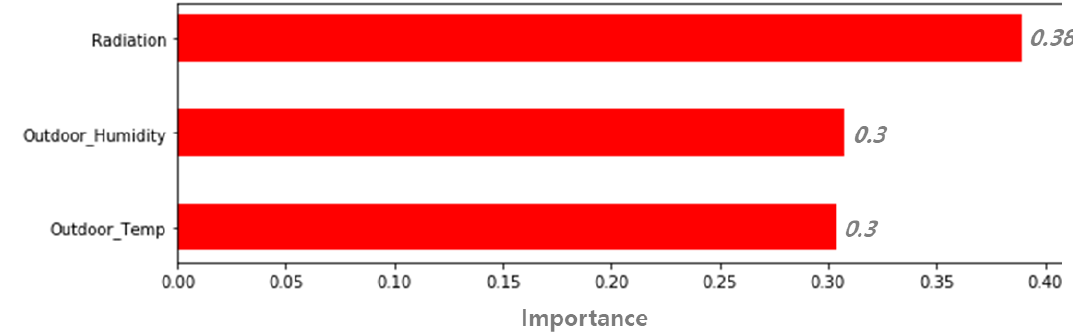
Figure 5. Gini importance of outdoor environmental data.